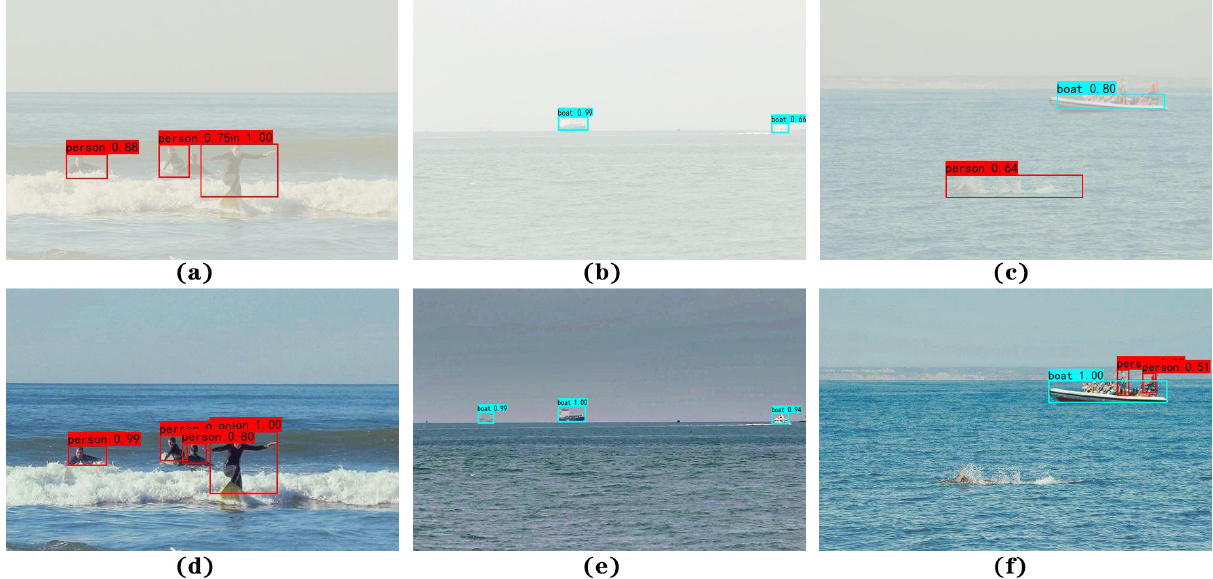
Figure 10. The performance comparison of YOLOv4-tiny and SRC-YOLO. The first row shows the detection results of the original YOLOv4-tiny model, while the second row is for SRC-YOLO. The subplots are the data containing marine boats and people before and after